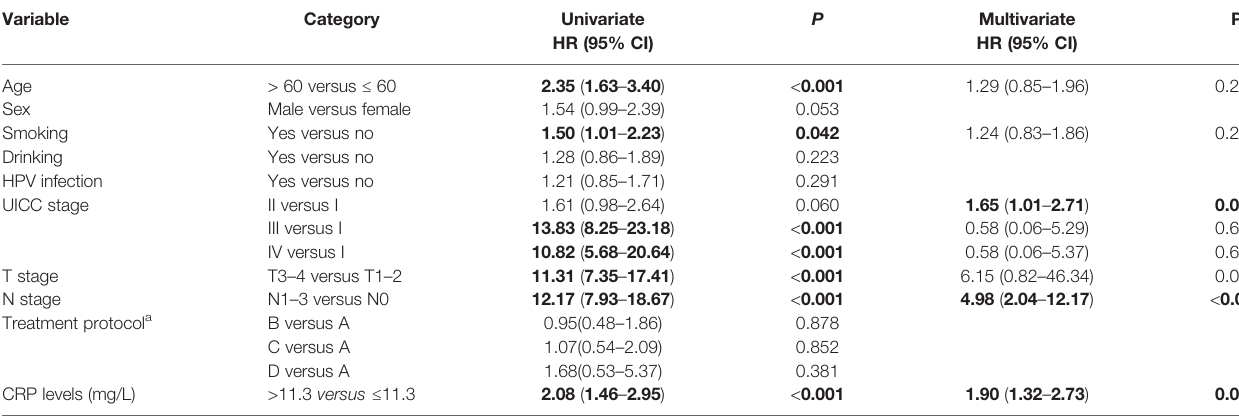
TABLE 2 | Univariate and multivariate analysis of prognostic factors affecting the overall survival in patients with HNSCC. Variable Category